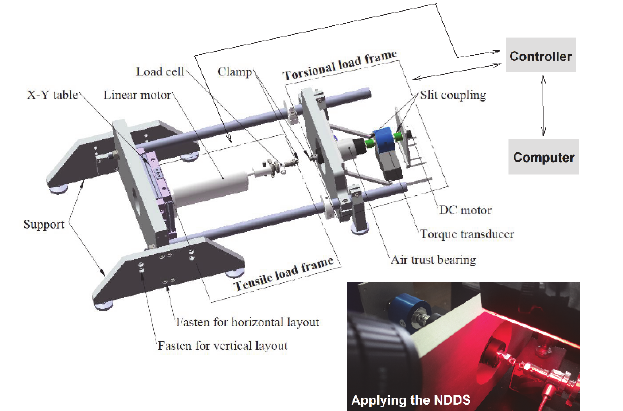
Figure 1: Schematic illustration of the tension-torsional fatigue apparatus for micro-scale